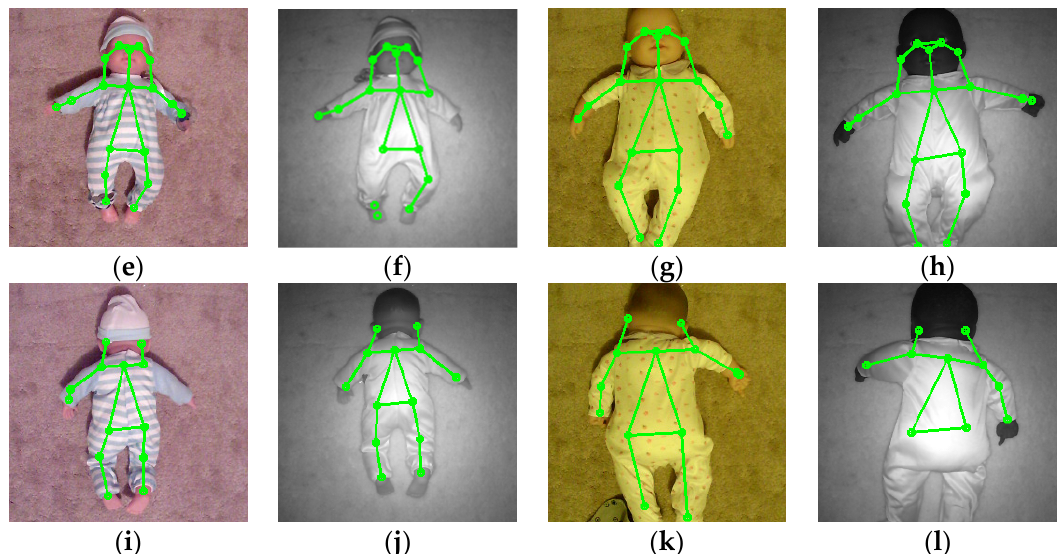
Figure 9. ( a – d ): captured images of dolls in the day and night conditions; ( e – h ) nose detected (with other body parts), indicating face is not covered; ( i – l ) nose undetected, indicating face is covered.